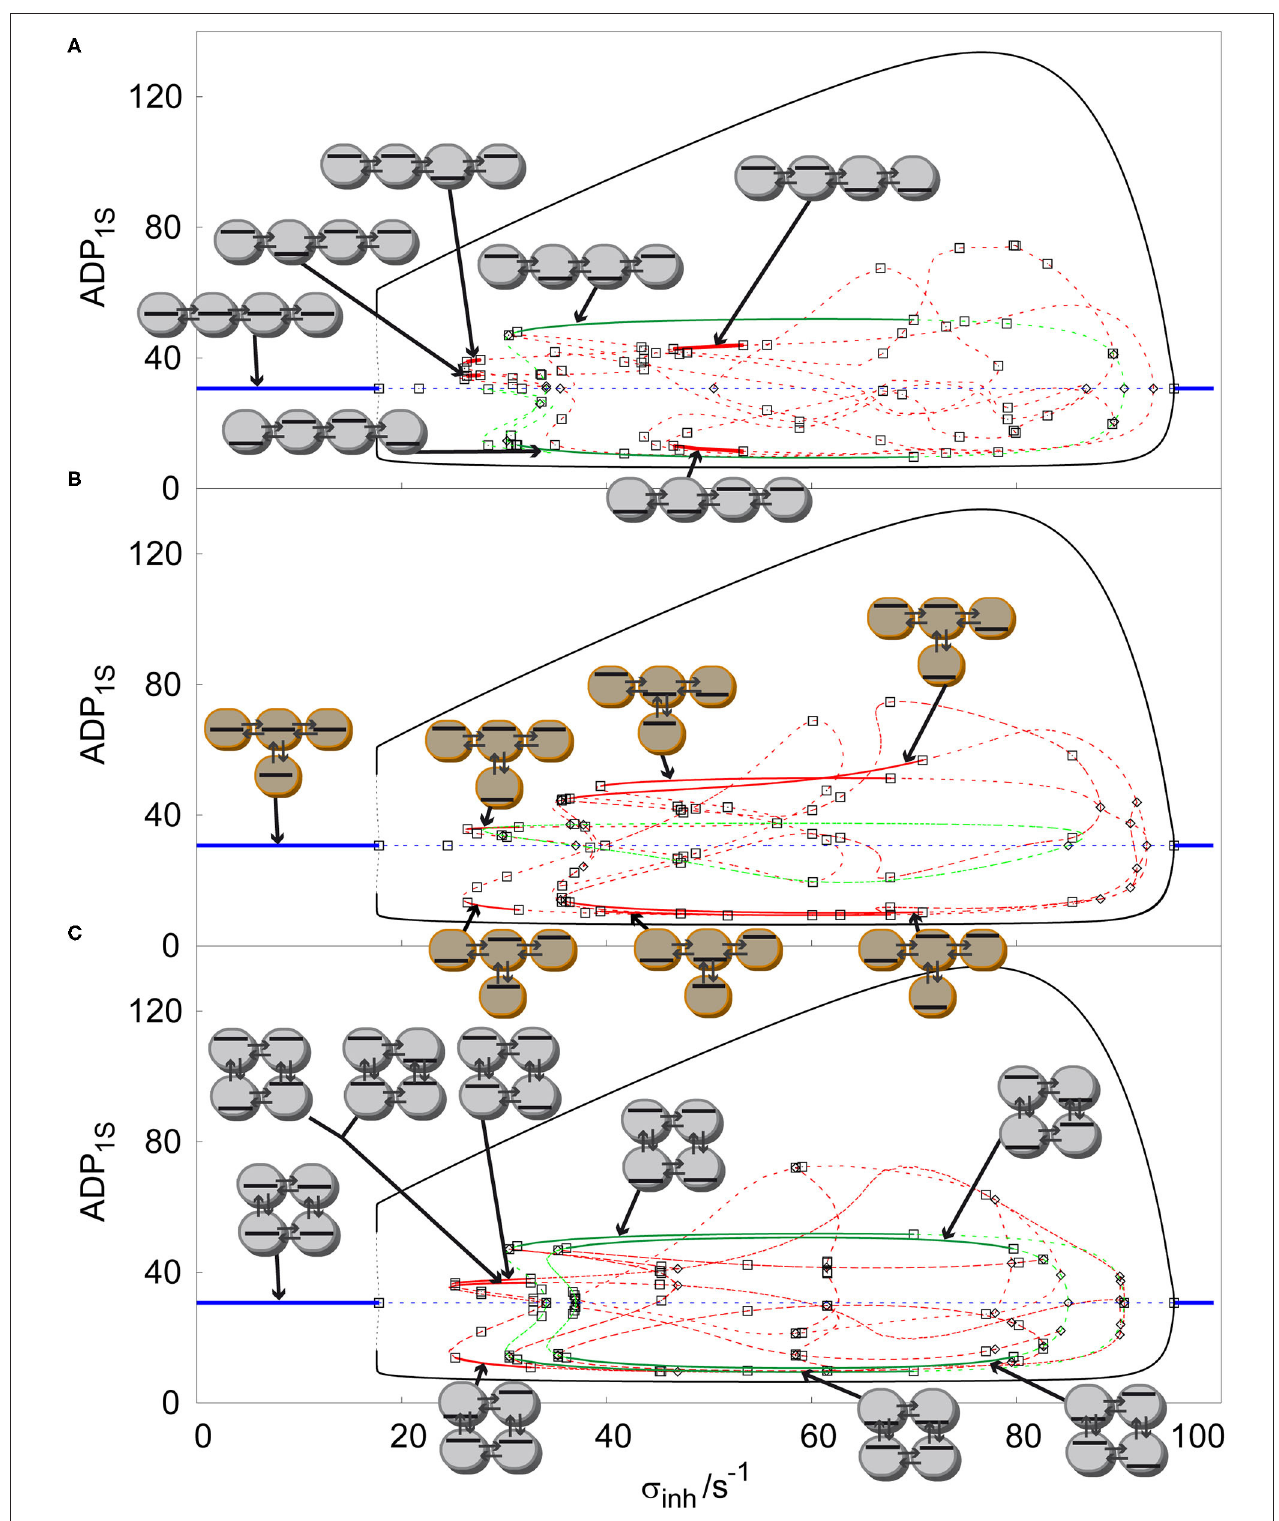
FIGURE 4 | Comparison of solution diagrams of four coupled cells q = 100, σ M = 100 s − 1 , k ADP = 0.10 s − 1 in: (A) linear array, (B) T-shaped array, (C) cyclic array. Red curve—asymmetric non-uniform stationary state; blue curve—homogeneous stationary state; green curve—symmetric non-uniform stationary state; full line –stable stationary solution, dashed curve- unstable stationary solution; empty square—Hopf bifurcation point; empty diamond—symmetry breaking bifurcation point. Each stable stationary state has assigned a symbolic representation of its pattern.